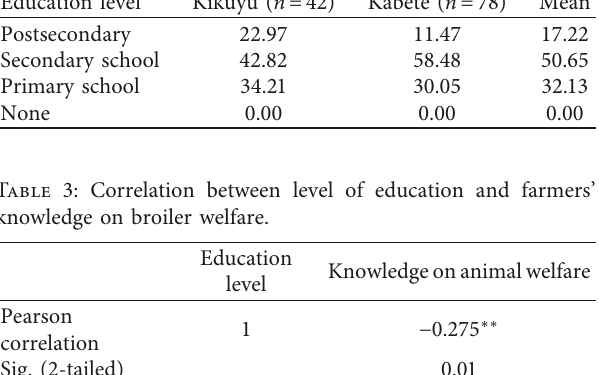
Correlation is significant at the 0.01 level (2-tailed). Table 4: Average land size of farmers in the study area. Land size (hectares/ farmer)